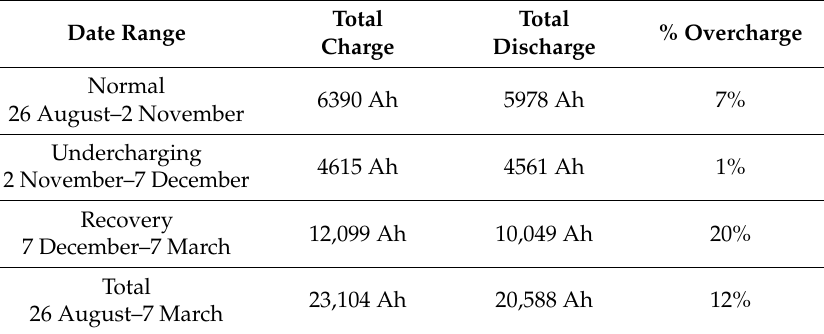
Table 2. Average amp-hour charge reconciliation per